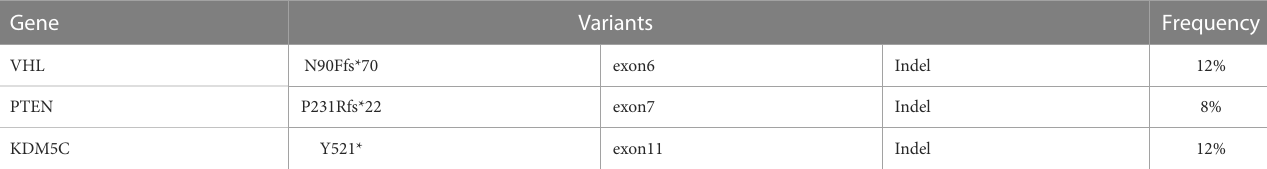
TABLE 1 The genetic testing results. Gene